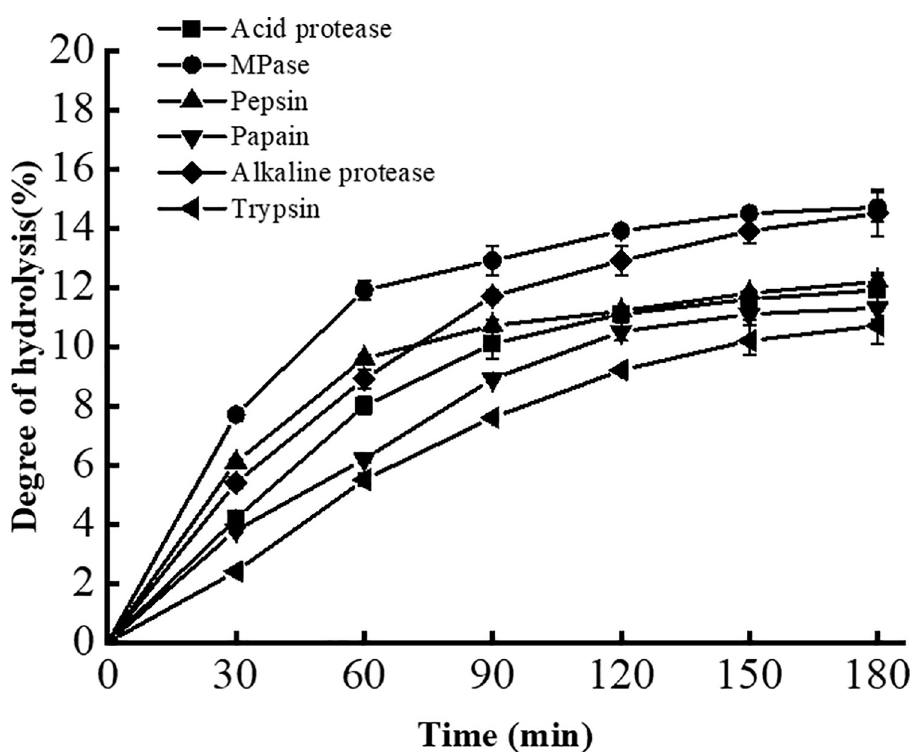
Fig 6. Determination of the degree of hydrolysis of soybean protein isolates by HypZn or five commonly used commercial proteases.